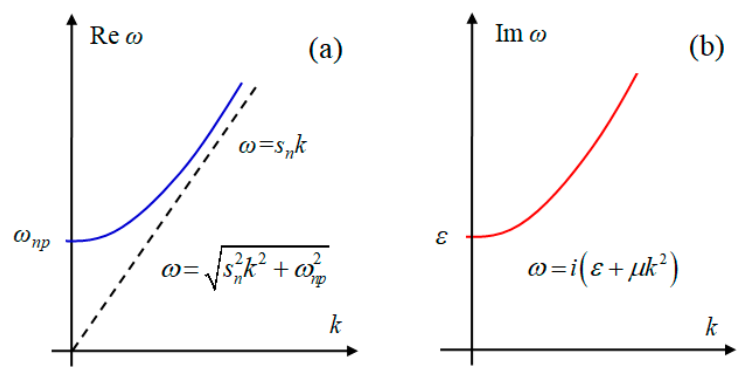
Figure 3. The schematic plots of dispersion curves for electron sound waves in normal metal. ( a ) The dependence of the frequency on the wave number. ( b ) The dependence of the decrement on the wave number.